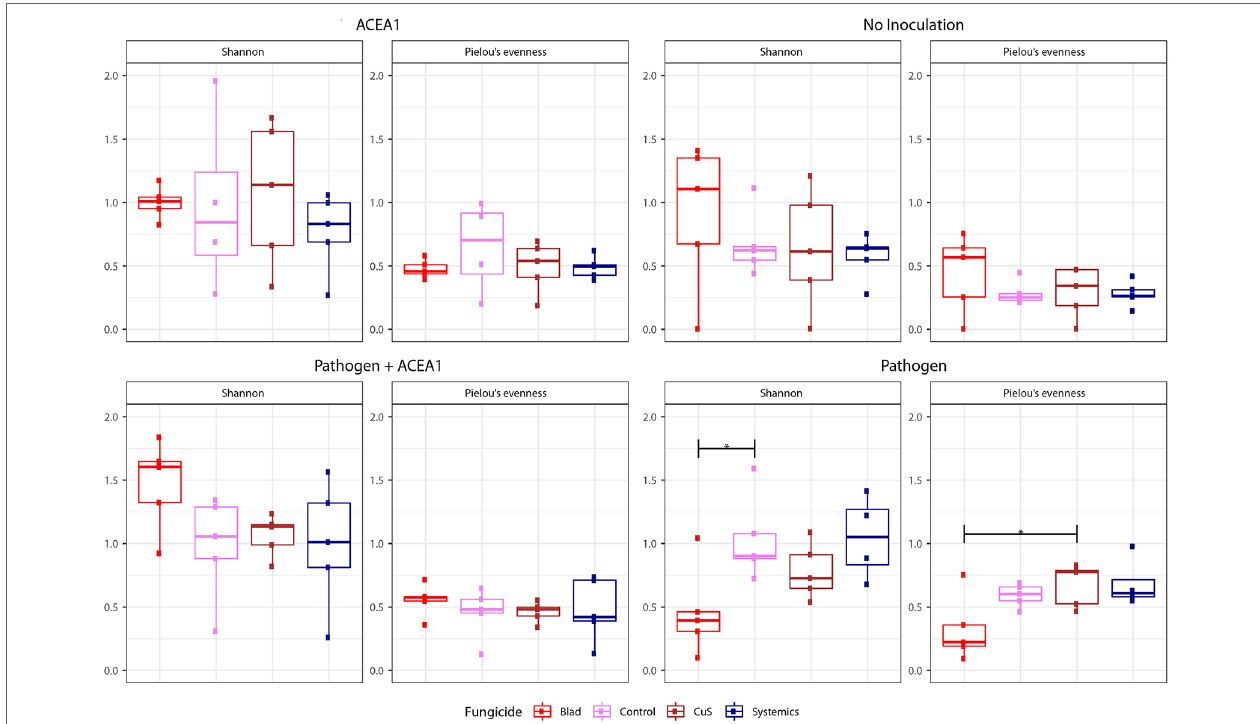
FIGURE 4 | Box plots of diversity indexes (Shannon, Pielou’s evenness) of the fungal community present in grapevine cuttings added with water (No inoculation) or inoculated with Phaeomoniella chlamydospora (Pathogen), a consortium of fungal wood endophytes (ACEA1), or both P. chlamydospora and ACEA1. Inoculated plants were sprayed with either Blad or potassium permanganate (Control) or copper oxychloride and sulfur (CuS) or penconazole and fosetyl-aluminum (Systemics). n = 5 for each combination inoculum/treatment. The black, horizontal brackets at the top of the figures denote statistical comparisons of the two treatments at each end of the bracket, calculated using one-way ANOVA with Tukey’s honestly significant difference (HSD) post hoc . Statistical differences are shown by asterisk, where * P 0.05.